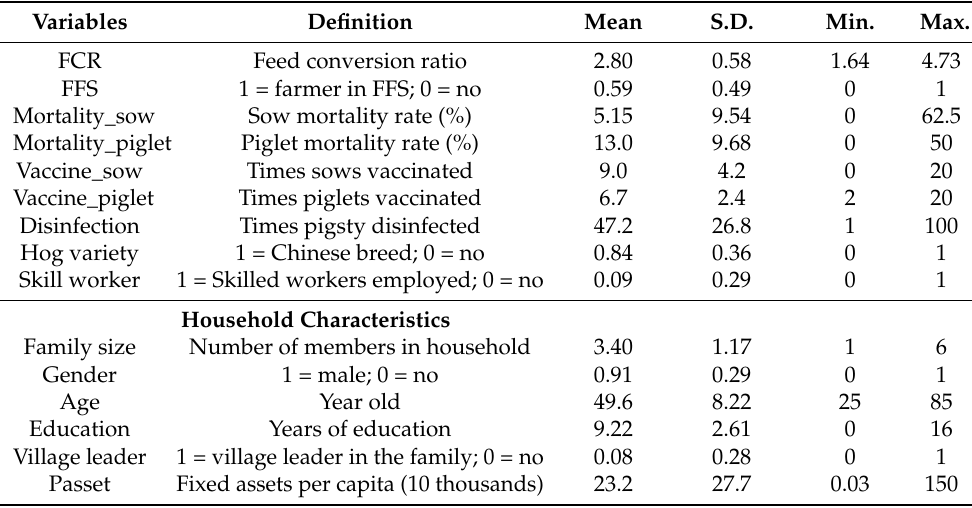
Table 3. Definition of variables and summary